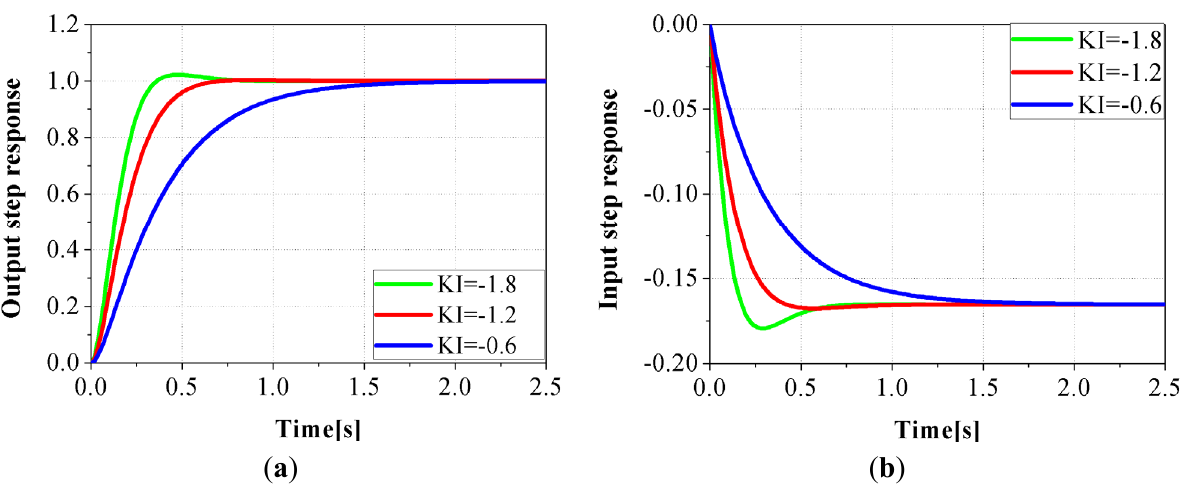
Figure 5. Step response curves of the system with the servo compensator. ( a ) Output step response; ( b ) Input step